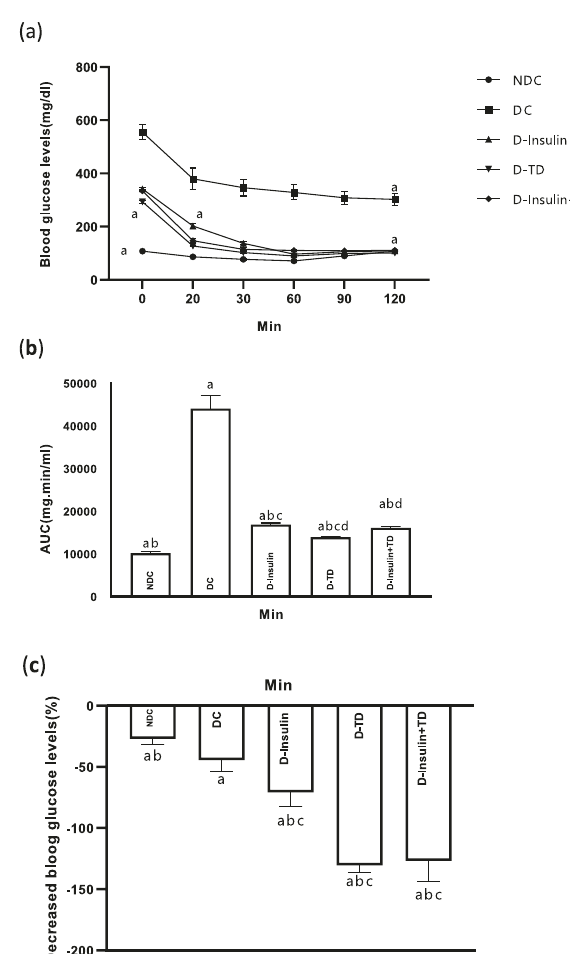
Fig. 3 Effect of TD on changes in blood glucose levels in the insulin tolerance test (ITT) of male rats. Comparison of the insulin tolerance test (ITT) in the last month ( a ) and the area under the curve (AUC) ( b ) and decreased blood glucose level ( c ) in the non- diabetic control (NDC), diabetic control (DC), D-insulin, D-TD, and D- insulin + TD groups. DC group received 60 mg/kg STZ. The D-insulin group diabetic animals were treated with 2.5 U/kg insulin twice per day (1/3 morning and 2/3 in the evening), D-TD group diabetic animals were treated with daily IP injection of 40 mg/kg thiamine disul fi de, D-insulin + TD group diabetic animals treated with TD and insulin (2.5 U/kg insulin + 40 mg/kg TD once per day). Data are expressed as mean ± S.E.M ( N = 7). a Signi fi cant difference in ITT and AUC between the DC group and other groups ( p < 0.0001) and signi fi cant difference in decreased blood glucose level (DC vs NDC ( p < 0.05), DC vs D-insulin ( p < 0.01), DC vs D-TD and D-insulin + TD ( p < 0.001). b Signi fi cant difference in AUC between the NDC group and other groups ( p < 0.0001) and signi fi cant difference in decreased blood glucose level (NDC vs D-insulin ( p < 0.01), NDC vs D-TD and D-insulin + TD ( p < 0.0001). c Signi fi cant difference between the D-insulin group and the other two treatments (D-TD and D-insulin + TD) groups ( p < 0.01) for AUC and ( p < 0.001) for a decreased blood glucose level. d Signi fi cant difference in AUC between the D-TD and D-insulin + TD groups ( p < 0.01).